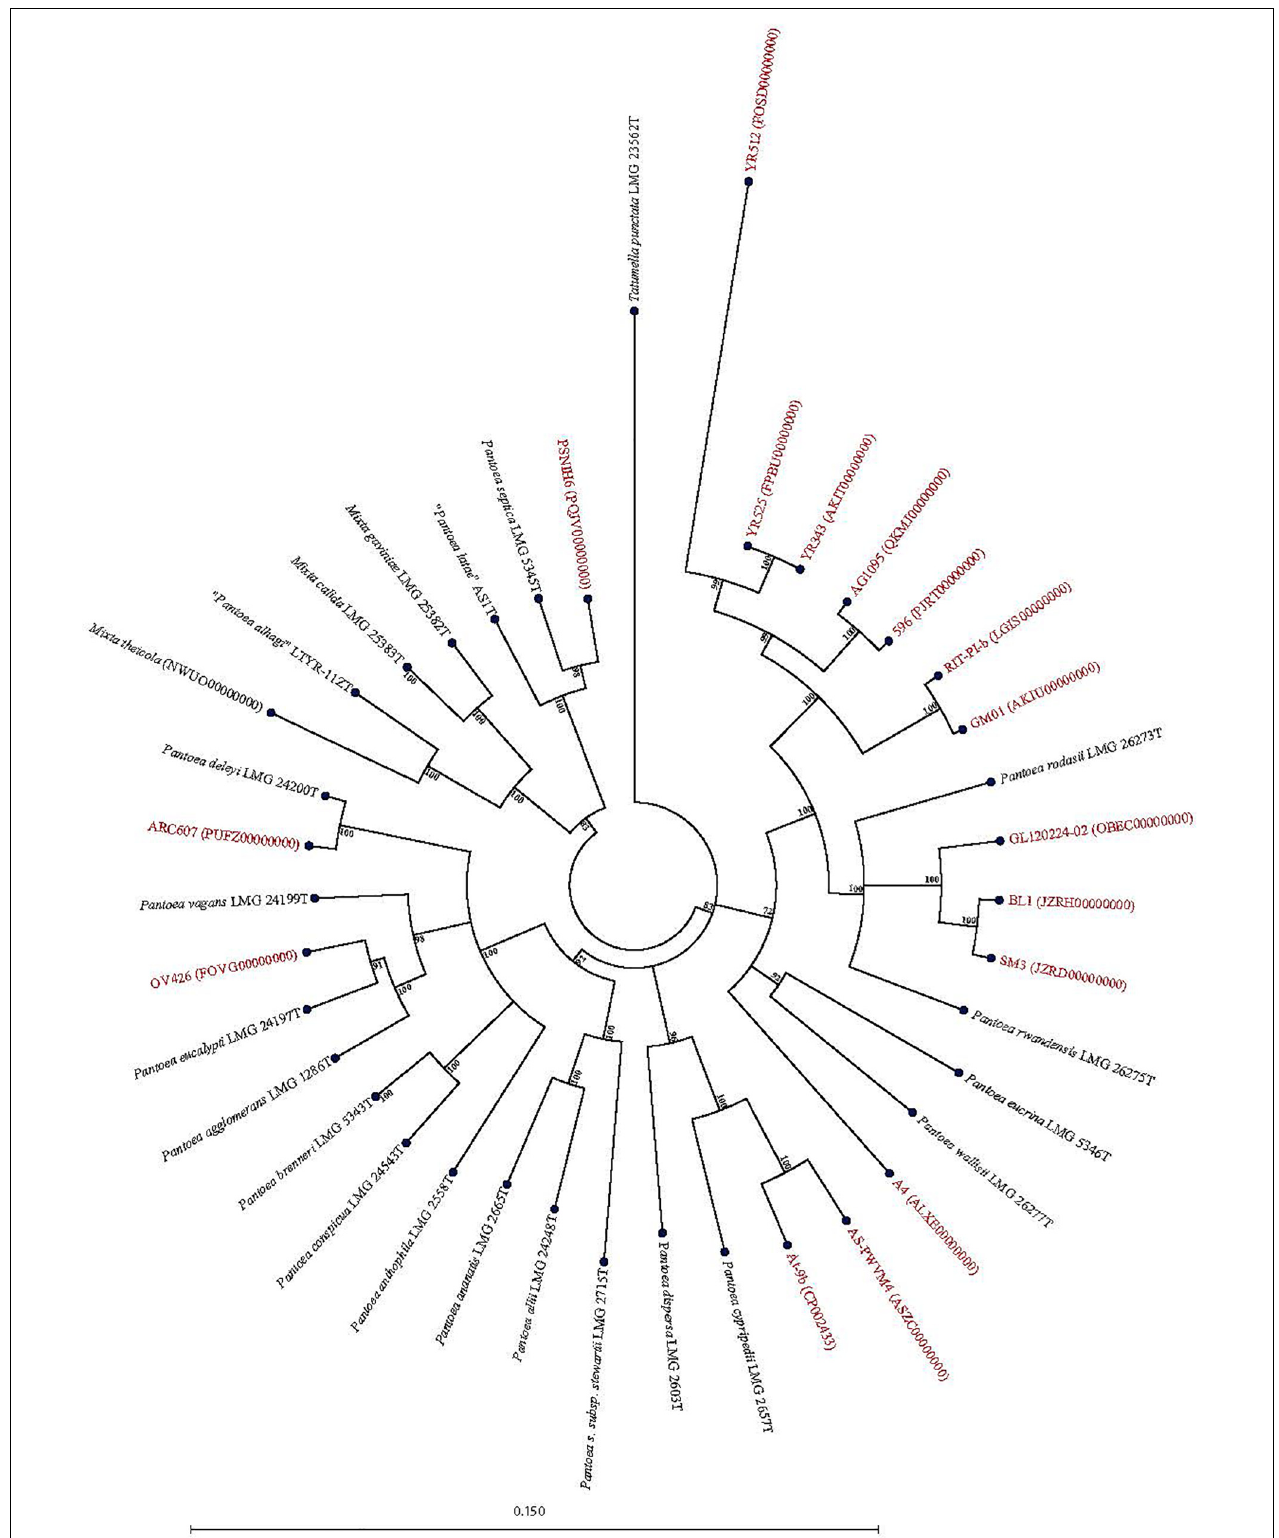
FIGURE 4 | Maximum Likelihood phylogenetic tree of potential novel Pantoea species (red) previously reported as Pantoea sp. in NCBI database in phylogenetic association with Pantoea, Mixta, and Tatumella type strains (black).